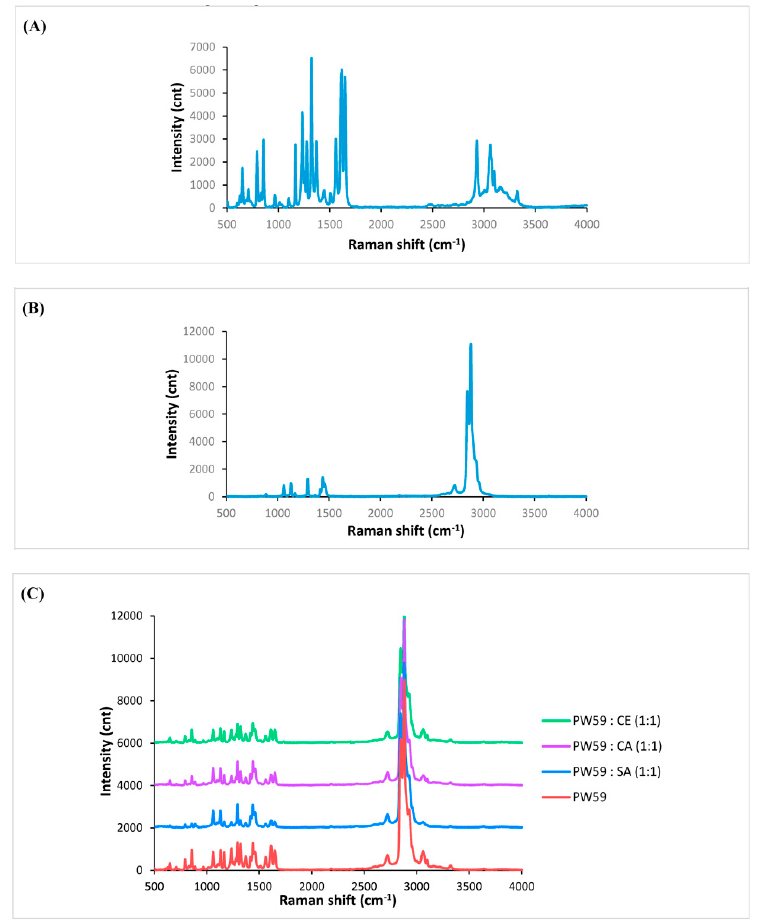
Figure 8. Raman spectra of ( A ) paracetamol, ( B ) PW59, and ( C ) spray-congealed microparticles ( n = 3). Note: The Raman spectra of SA, CA, and CE were similar to PW59, so only the PW59 spectrum is